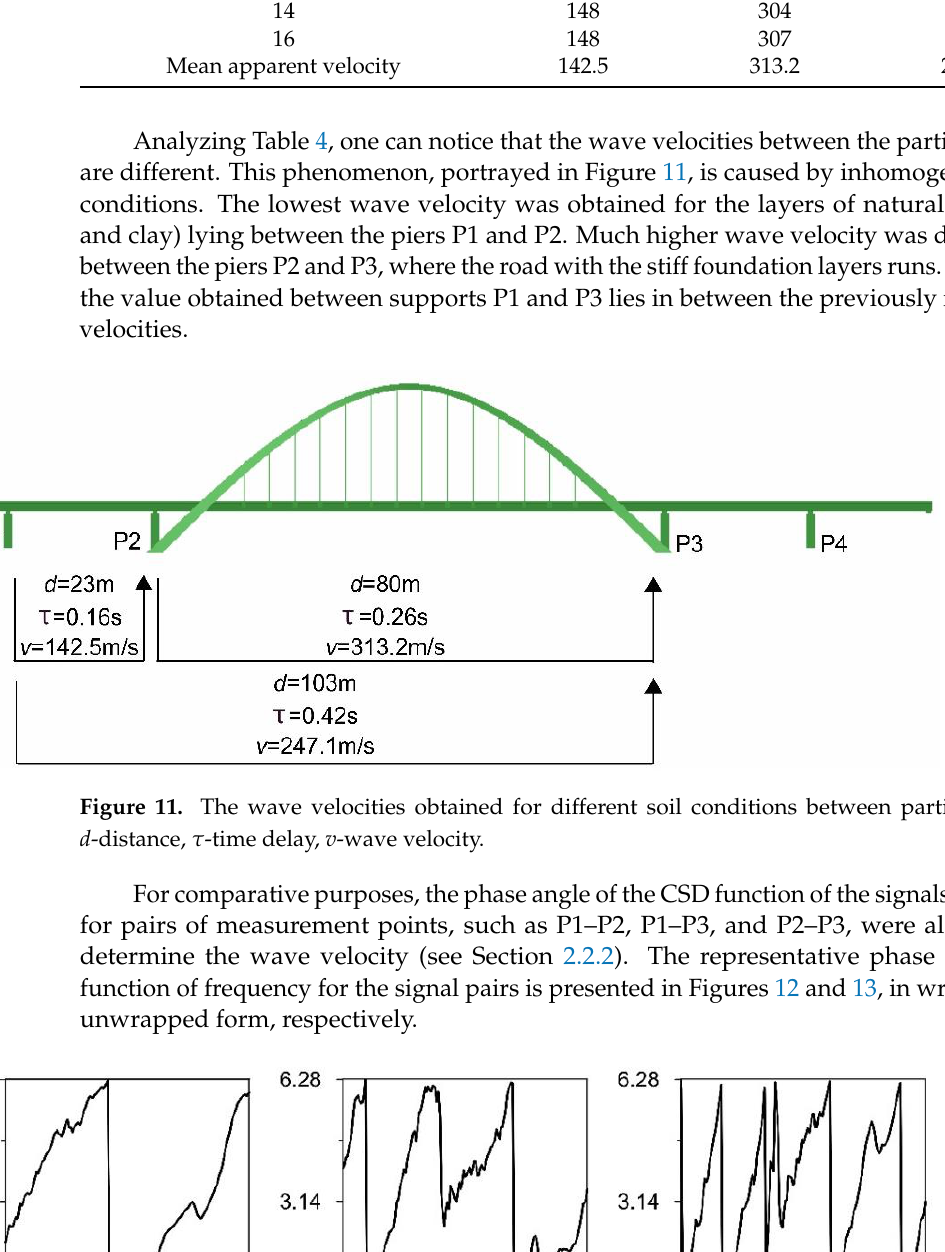
( c ) Figure 13. The function of phase angle in unwrapped form for pairs: ( a ) P1 – P2, ( b ) P1 – P3, ( c ) P2 – P3. Based on the phase angle function, the time delay of the wave was determined for the support pairs (see Equation (19)) and the selected frequencies. As previously men- tioned, the mean wave velocities between the particular piers (averaged over five series) and the mean apparent wave velocities between support pairs (averaged over different frequencies) are presented (Table 5). Table 5. The mean value of the wave velocity between supports determined by the unwrapped phase angle function. Wave Component Frequency [Hz]